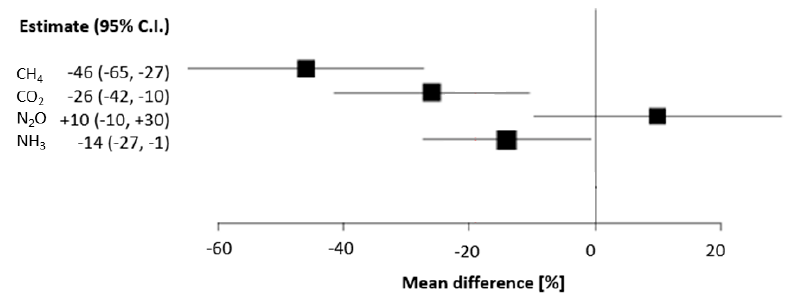
Figure 2. Forest plot of the impact of biological treatment of animal slurry with reference to raw slurry. The black square boxes show the individual mean points of each gas. Horizontal bars indicate the 95% confidence intervals.